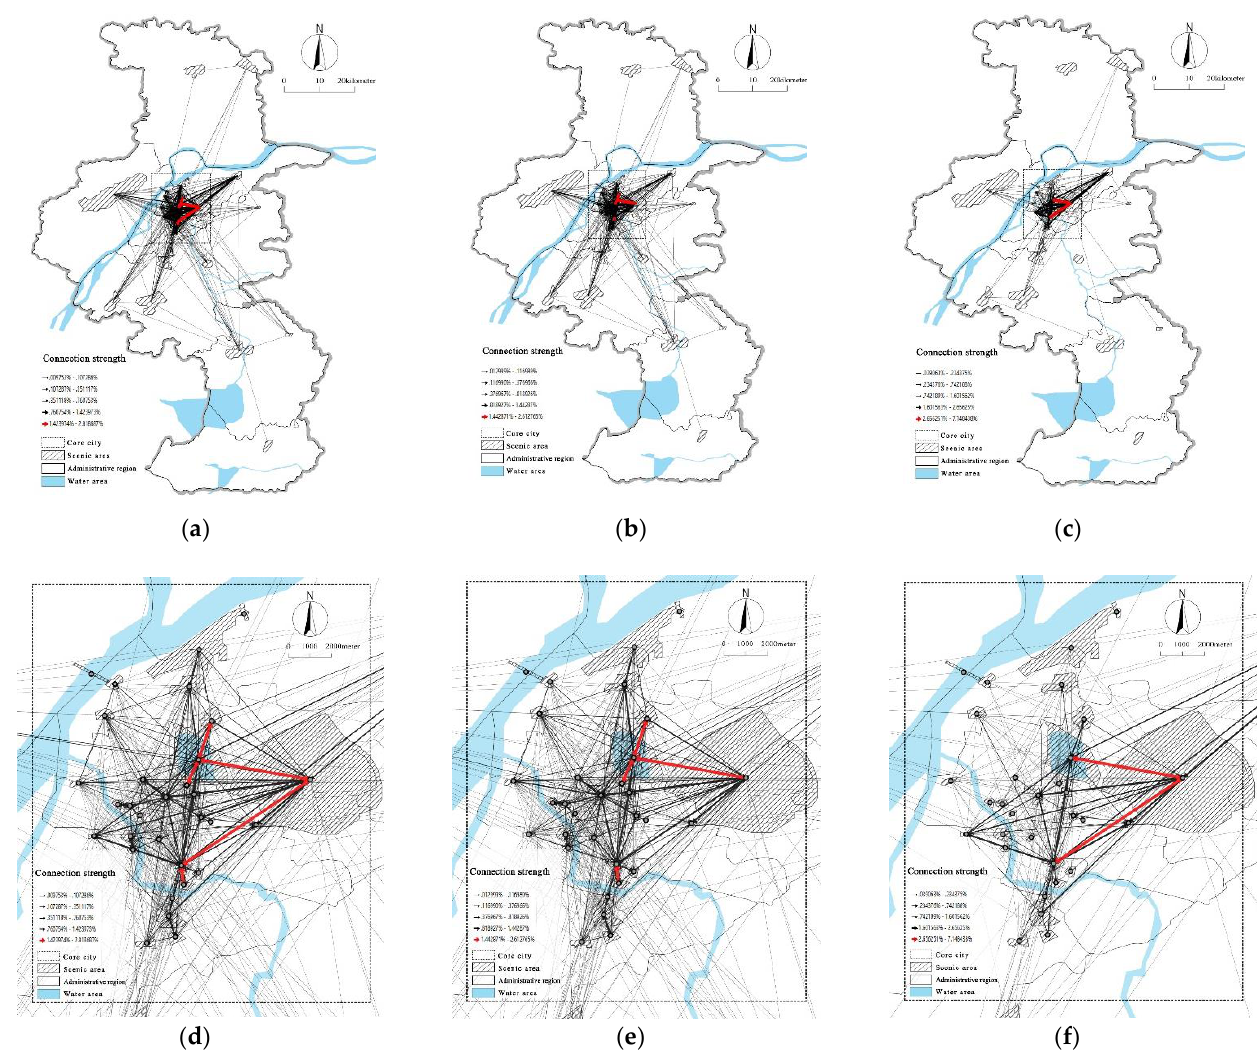
Figure 4. Connection strength of tourism flow networks under three types of network context (overall, resident, and non-local tourist): ( a ) overall tourism flow strength of entire city; ( b ) resident tourism flow strength of entire city; ( c ) non-local tourism flow strength of entire city; ( d ) overall tourism flow strength of core city; ( e ) resident tourism flow strength of core city; ( f ) non-local tourism flow strength of core city.